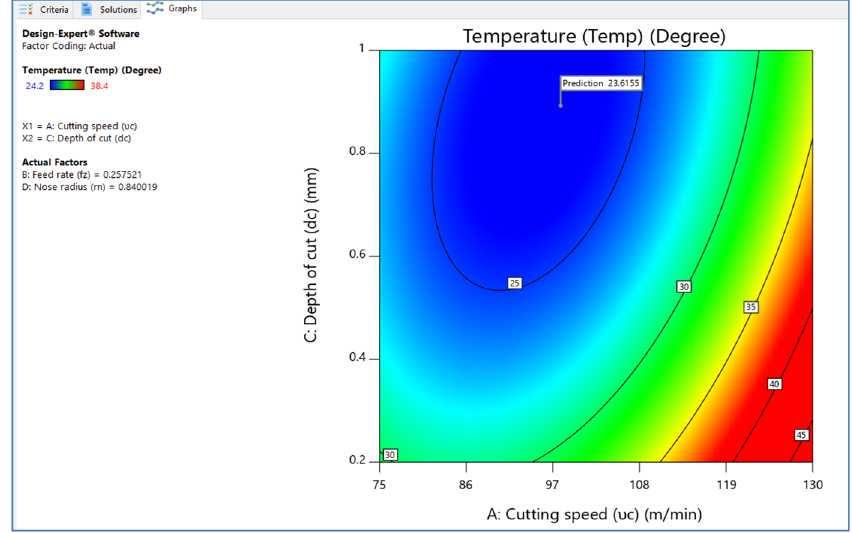
Figure 7. Contour plot on desirability (V c vs. D c ).